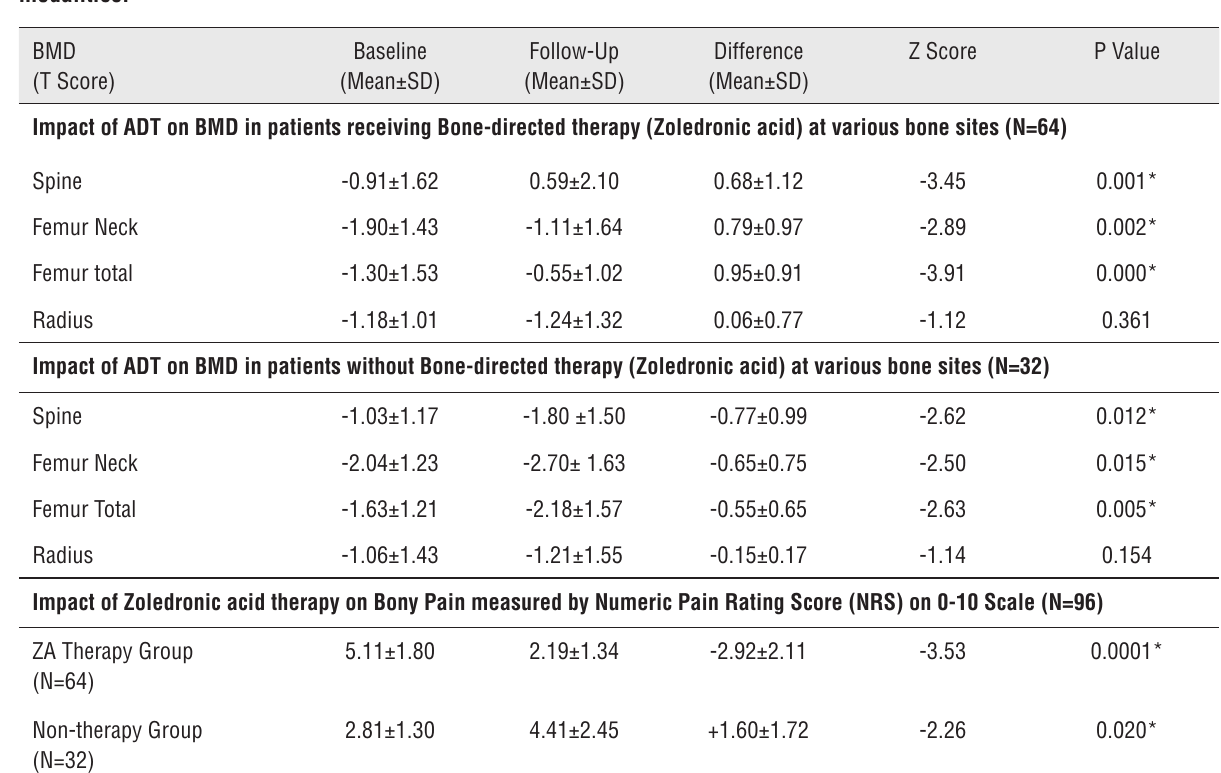
Table 3 - Comparison of baseline and follow up BMD at various bone sites and Pain Scores with different therapeutic modalities.